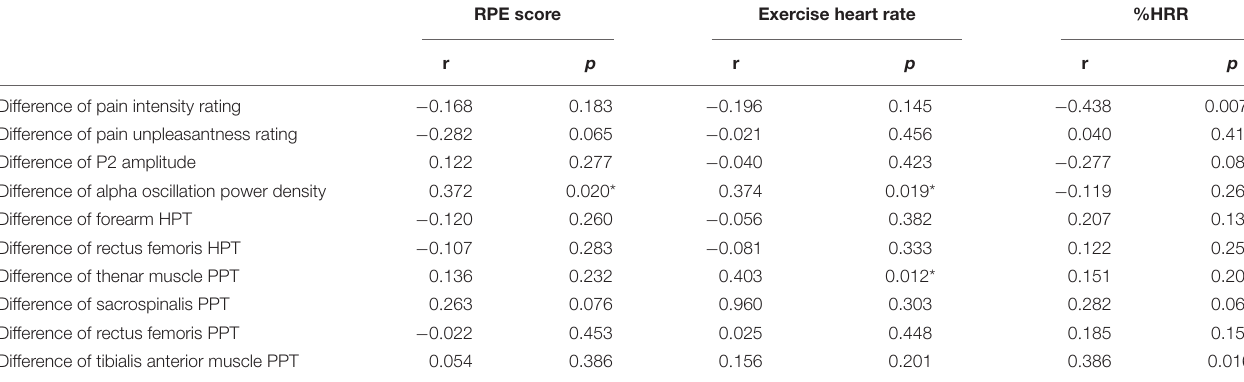
TABLE 4 | The correlation between the three exercise intensity indexes with the difference of various indicators before and after intervention. RPE score Exercise heart